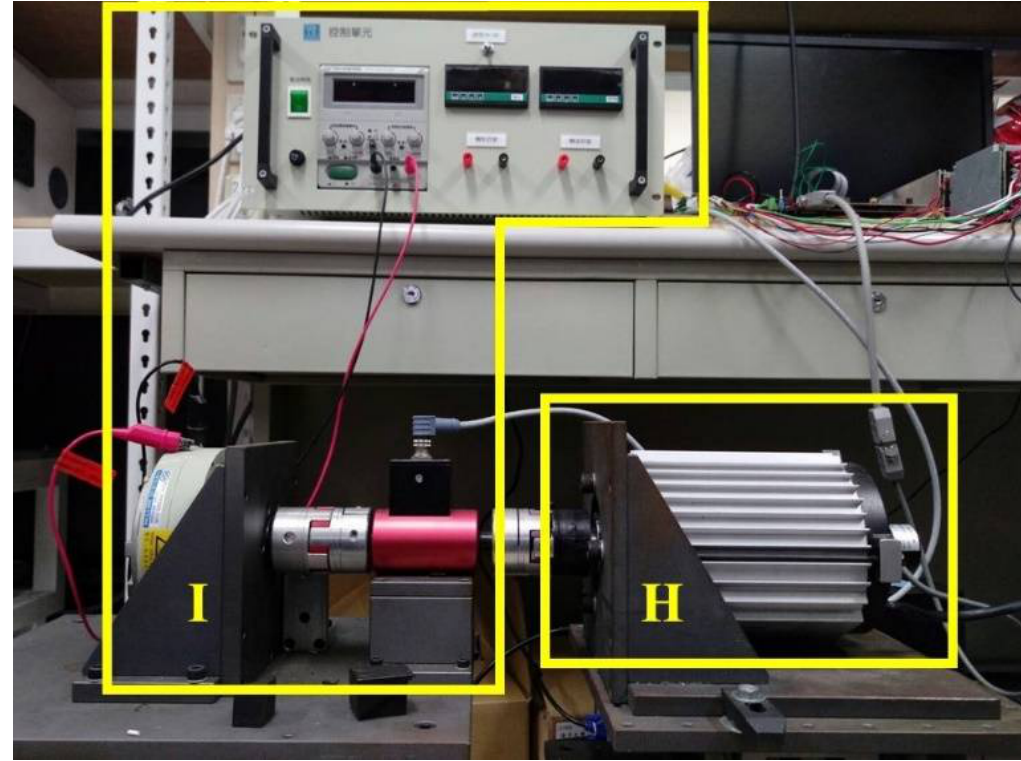
Figure 7. The SynRM connected to a torque meter.